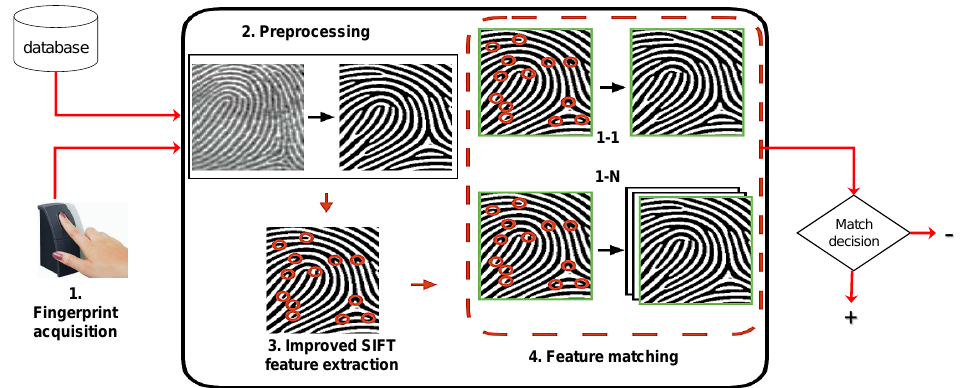
Figure 2. A functional block diagram of the automated fingerprint